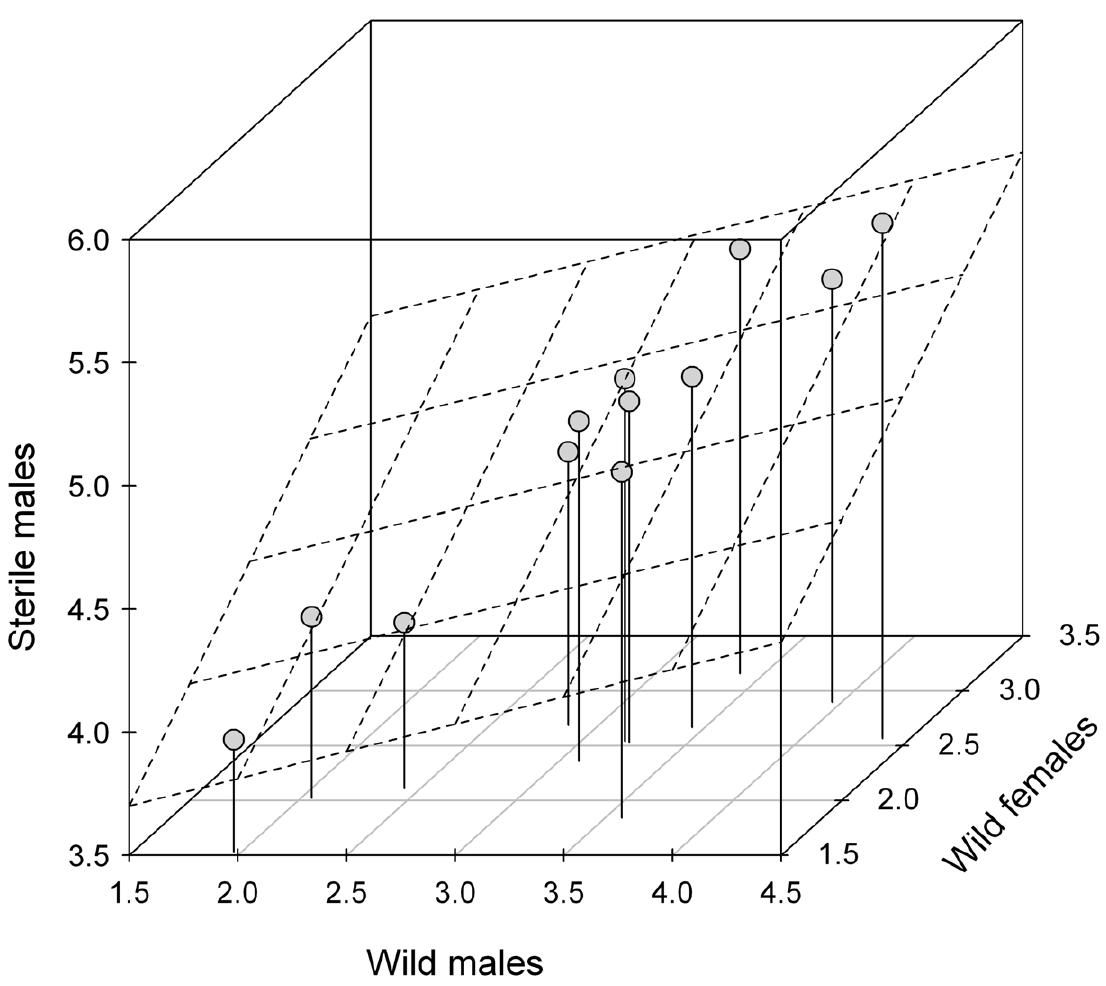
Figure 2. Joint distribution of wild and sterile Glossinaausteni in the Jozani-Chwaka Bay National Park. Data are log counts from which spatial trends have been removed. A regression plane (dashed lines) of sterile male fly counts versus wild fly counts (males and females) was added to the scatter plot ( R 2 =0.95, p , 10 2 4 ).